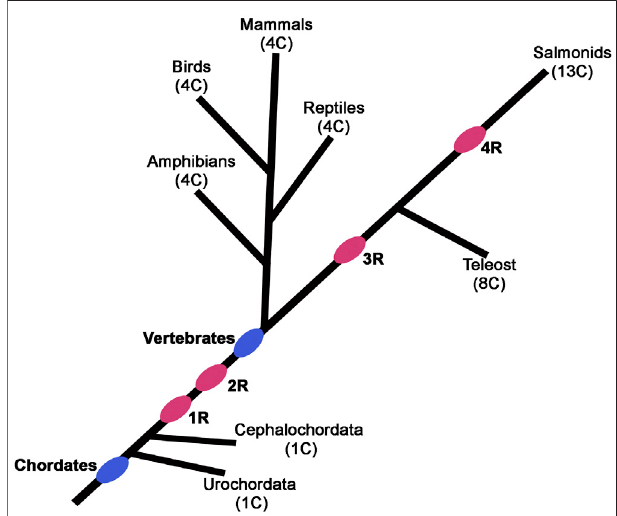
FIGURE 2 | Phylogenetic tree depicting the position of postulated whole-genome duplication (R) events during vertebrate evolution. The pink ovals indicate the progressive rounds of whole-genome duplication. The number of Hox clusters (C) in the different species is indicated in